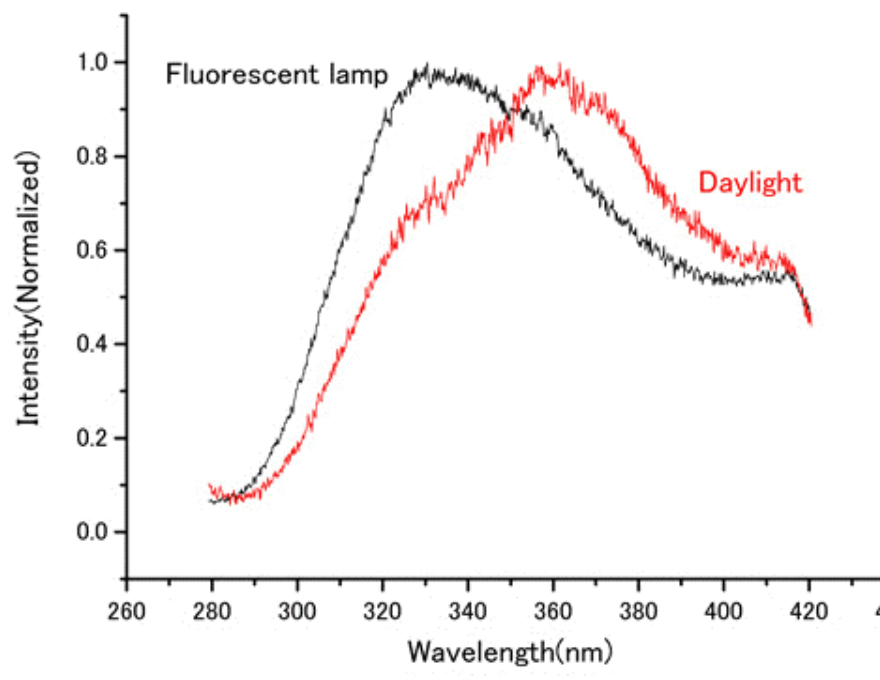
FIGURE 13. Fluorescence spectra of peak A after being left 14 days in ambient